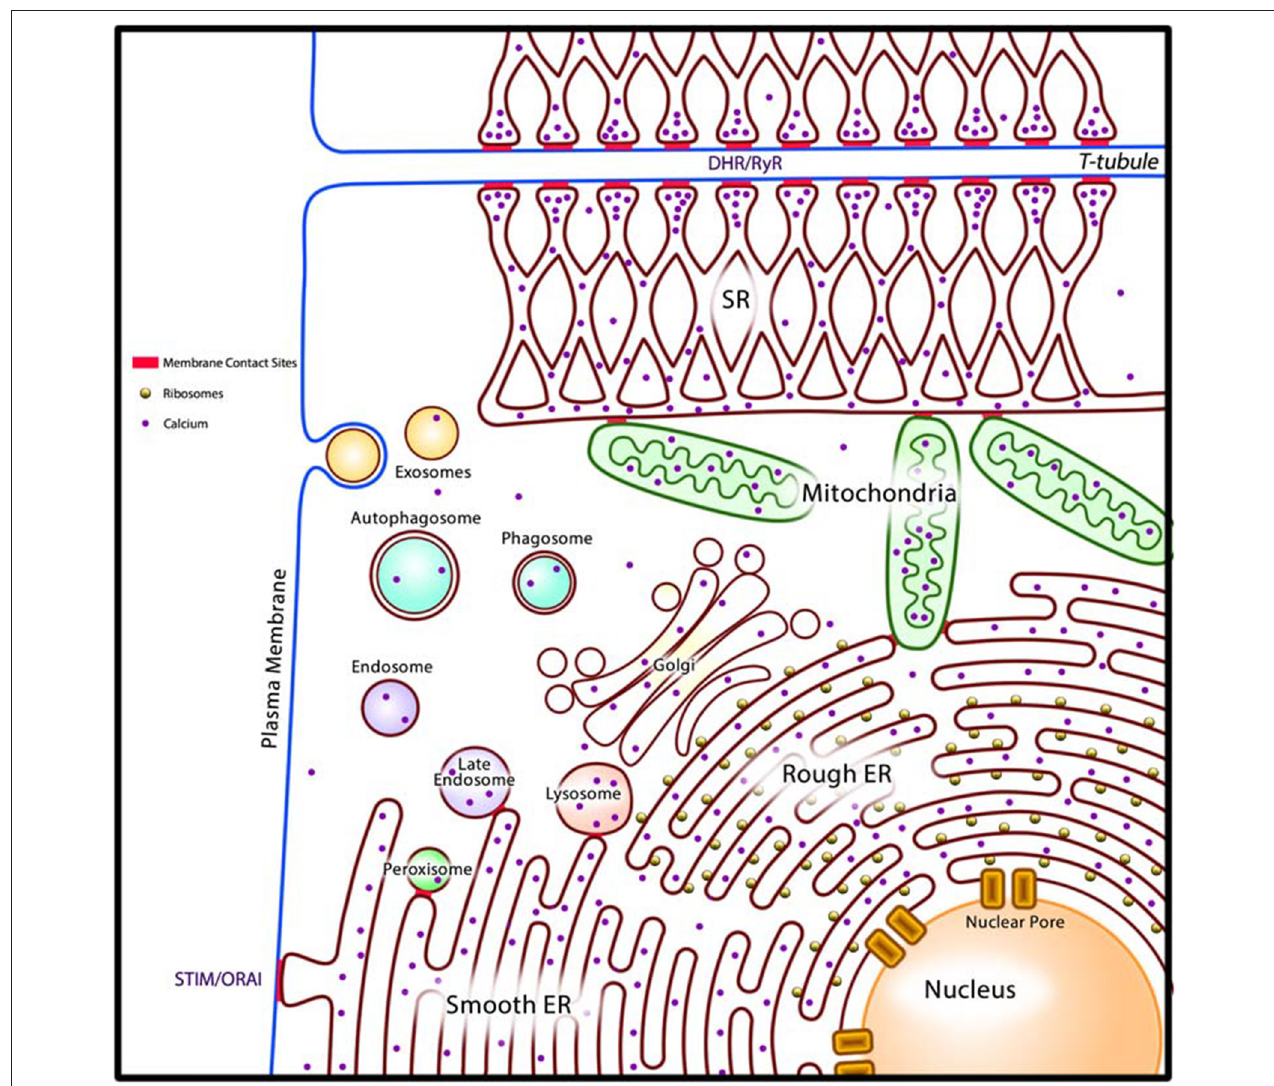
FIGURE 2 | A generalized model of the cardiac cellular reticular network (CRN). Intracellular organelles (rough and smooth ER, SR in cardiomyocytes and smooth muscle cells, Golgi apparatus, lysosomes, membranous components of the endocytic pathway, peroxisomes, and nuclear envelope) are organized into the cellular reticular network (CRN). The CRN is linked by membrane contact sites (MCS, in red) allowing for rapid exchange of molecules between component organelles. In cardiomyocytes the MCS that join SR and T-tubules (DHR/RyR) allow communication between the plasma membrane and the SR to drive E-C coupling. Smooth ER form MCS with the plasma membrane (STIM/ORAI) to drive store-operated Ca 2 + entry (SOCE). DHR, plasma membrane dihydropyridine Ca 2 + channel receptor; RyR, SR ryanodine receptor/Ca 2 + channel; STIM, ER Ca 2 + sensor; ORAI, plasma membrane Ca 2 + channel; ER, endoplasmic